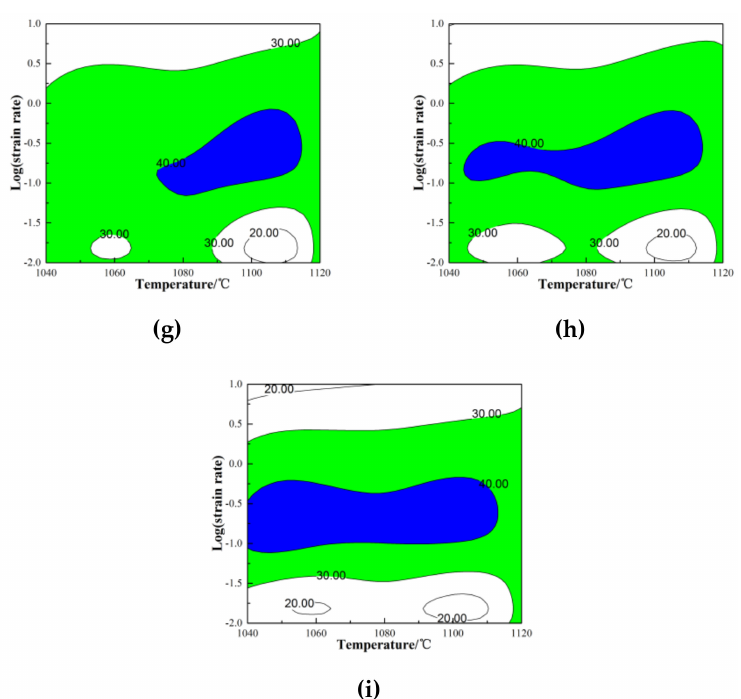
Figure 8. The processing map of efficiency of power dissipation (%) under strains of 0.1~0.9: The blue regime: 30% < η < 40%, the green regime: 40% < η < 50%, the red regime: η > 50%. ( a ) ε = 0.1; ( b ) ε = 0.2; ( c ) ε = 0.3; ( d ) ε = 0.4; ( e ) ε = 0.5; ( f ) ε = 0.6; ( g ) ε = 0.7; ( h ) ε = 0.8; ( i ) ε = 0.9.